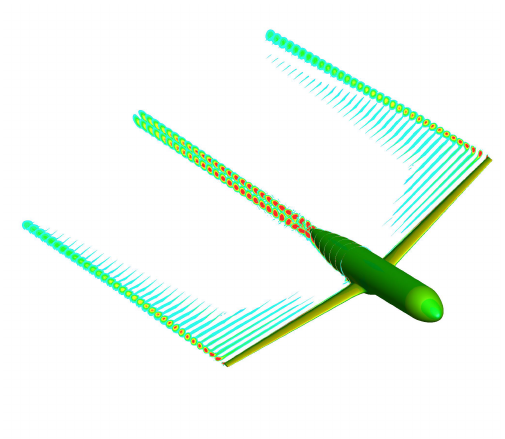
Figure 10. NASA CRM wing body configuration: M ∞ = 0.85, Re ∞ = 5 × 10 6 . Lift drag polar curves [16].